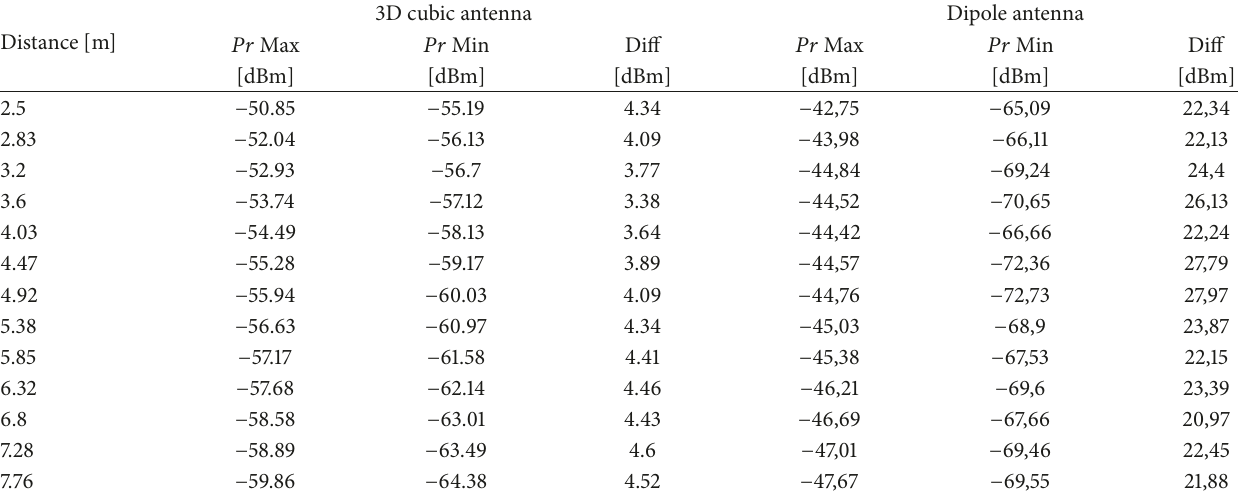
Table 7: Difference between 𝑃𝑟 Max and Min in the OLOS scenario.